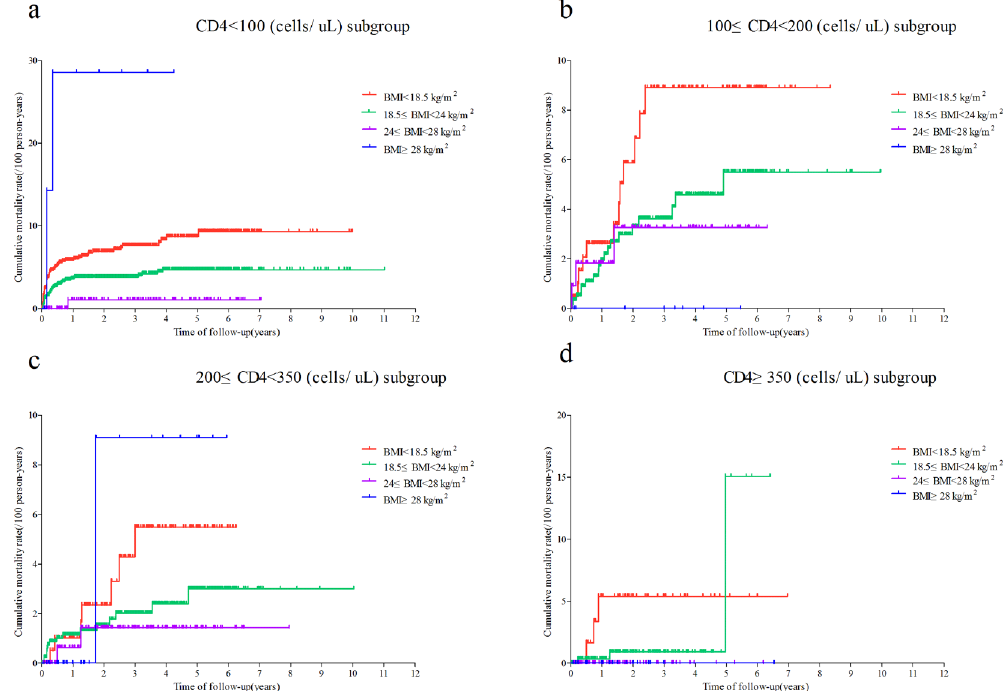
Figure 3. Kaplan-Meier Survival Curves for the four weight groups in each stratum of CD4 T cell count. ( a ) Cumulative mortality rate of HIV-infected patients in the “CD4 < 100/ µ L” subgroup. ( b ) Cumulative mortality rate of HIV-infected patients in the “100 ≤ CD4 < 200/ µ L” subgroup. ( c ) Cumulative mortality rate of HIV-infected patients in the “200 ≤ CD4 < 350/ µ L” subgroup. ( d ) Cumulative mortality rate of HIV-infected patients in the “CD4 ≥ 350/ µ L”